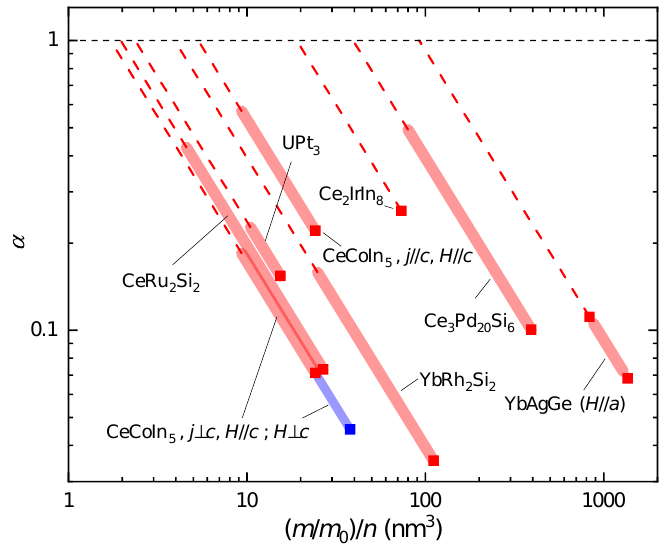
Figure 4. No Planckian dissipation from heavy quasiparticles in heavy fermion compounds. Double- logarithmic plot of α vs. ( m / m 0 ) / n for various strange metal heavy fermion compounds, as given in Table 1. Red squares and shaded lines have the same meaning as in Figure 3. The dashed lines are to help reading off the values of ( m / m 0 ) / n for which the linear-in-temperature electrical resistivity in these compounds could be governed by Planckian dissipation. Note that in all cases the “Planckian dissipation” effective masses obtained in this way are sizeably smaller than even the smallest values experimentally accessed by tuning the systems away from the strange metal regime (top end of full shaded